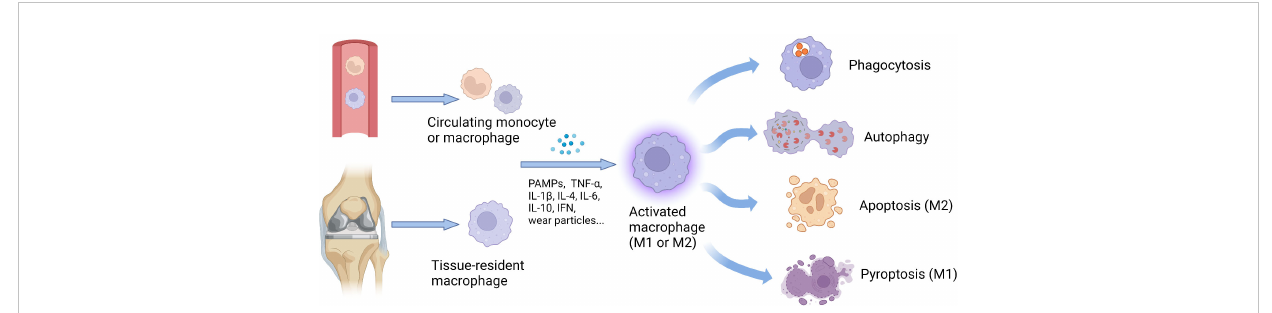
FIGURE 1 Origin and functional changes of macrophages. The number of tissue-resident macrophages can increase exponentially, including locally proliferating macrophages and monocytes recruited from the circulating peripheral blood. Stimulated by various factors, such as cytokines, PAMPs, and wear particles, the macrophages with different origins could be activated and further polarize into M1 or M2 phenotype. According to cellular phenotypes, activated macrophages show diverse functions, including phagocytosis, autophagy, apoptosis, and pyroptosis, to defend against infections and present antigens to other immune cells, thereby regulating the immune responses. IFN, interferon; IL, interleukin; M1, classically activated macrophages; M2, alternatively activated macrophages; PAMPs, pathogen-associated molecular patterns; TNF- a , tumor necrosis